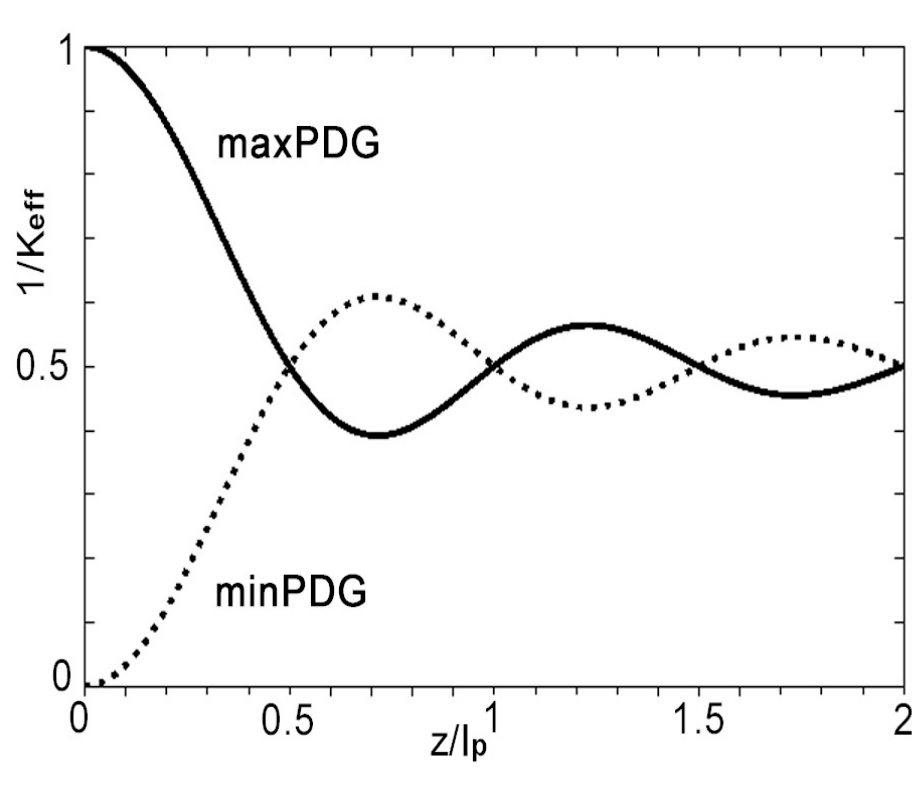
Figure 1. K PDG vs. the normalized distance z / l p ef f